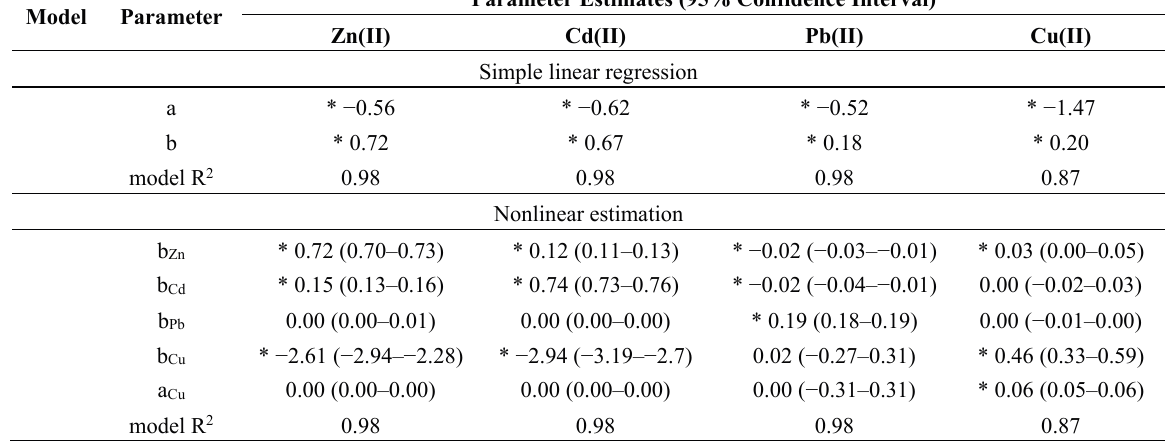
Table 1. Parameter estimates for simple regression and nonlinear estimation used in the optimization steps of the model. Parameters a and b for each metals are those used in the Equations (1) and (2). * indicate parameter is significant for calculation and therefore was used for the model.